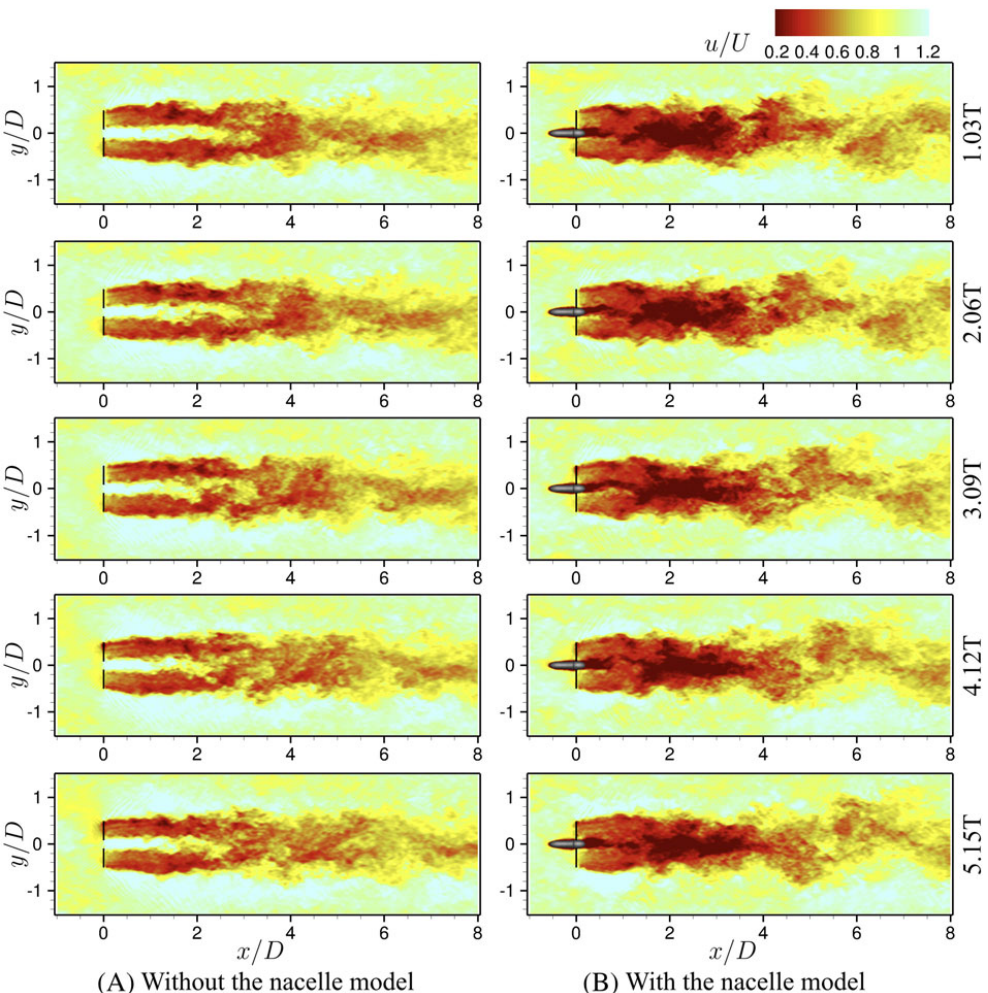
Figure 4. Contours of instantaneous streamwise velocity behind a hydro-kinetic turbine at different time instants without ( A ) and with ( B ) the actuator nacelle model. Reprinted with permission from Yang and Sotiropoulos [10], 2018, John Wiley and